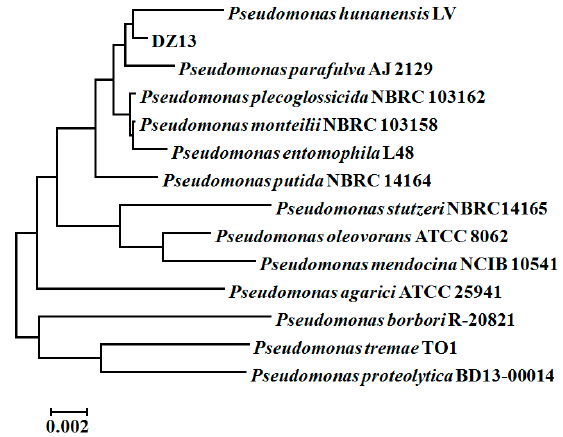
Figure 1. Phylogenetic tree of Pseudomonas sp. DZ13 based on 16S rRNA sequences. The tree is constructed by the neighbor-joining method of the bootstrap test (1000 replicates). The tree is drawn to scale, with branch lengths in the same units as those of the evolutionary distances used to infer the phylogenetic tree. All positions containing gaps and missing data were eliminated from the dataset (Complete deletion option).